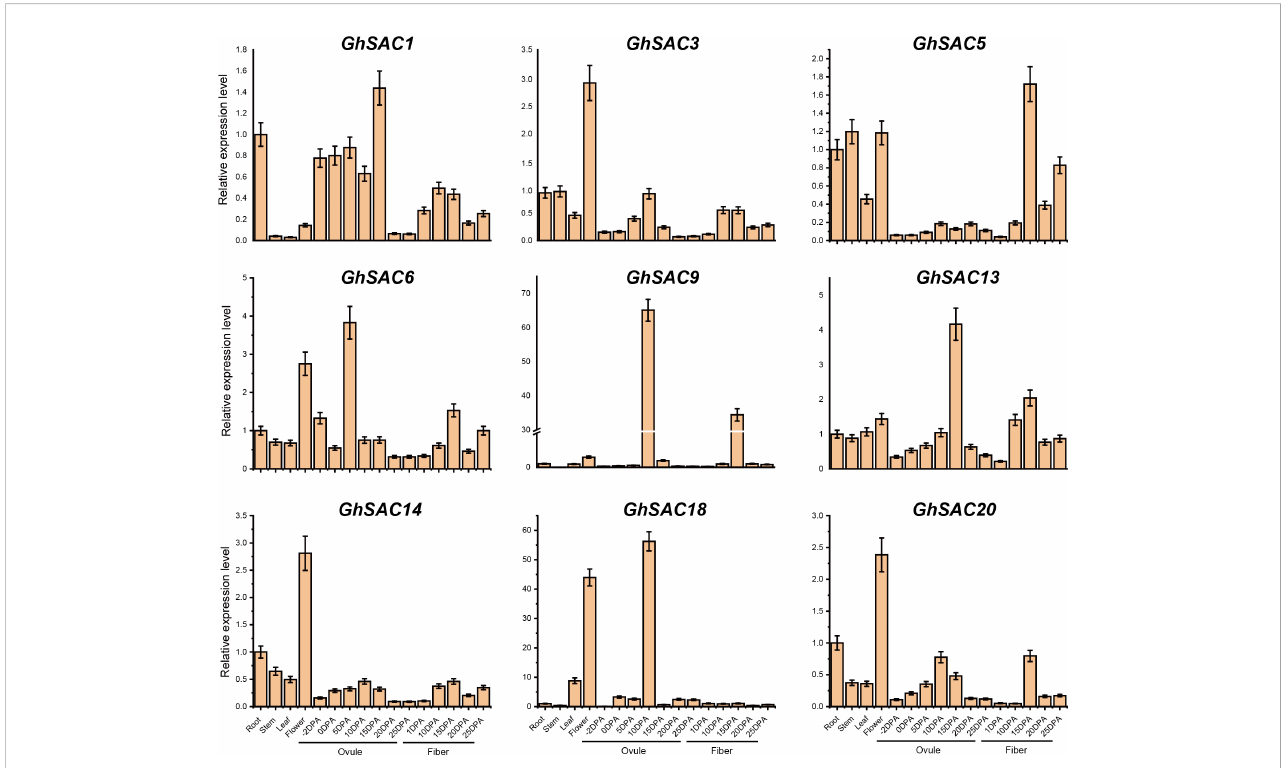
FIGURE 5 Expression pattern analysis of GhSAC genes. qRT-PCR analysis was performed to observe the relative expression patterns of GhSAC genes in vegetative, ovule, and fi ber tissue of the cotton plant. Each experiment was conducted in three biological repeats and the error bar represents the standard deviation among